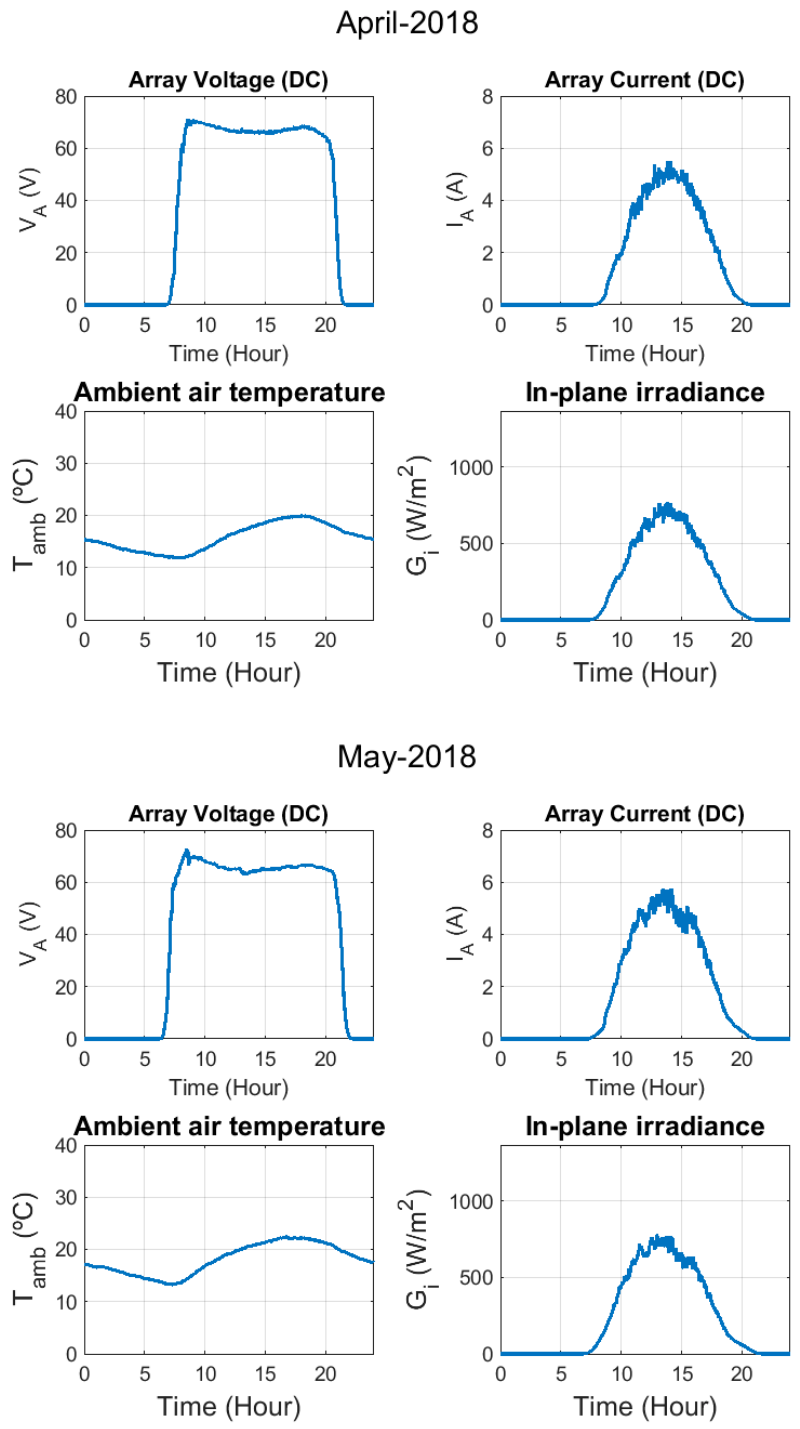
Figure A2. Daily monthly average values of V A , I A , T amb and G i from June 2017 to May 2018.